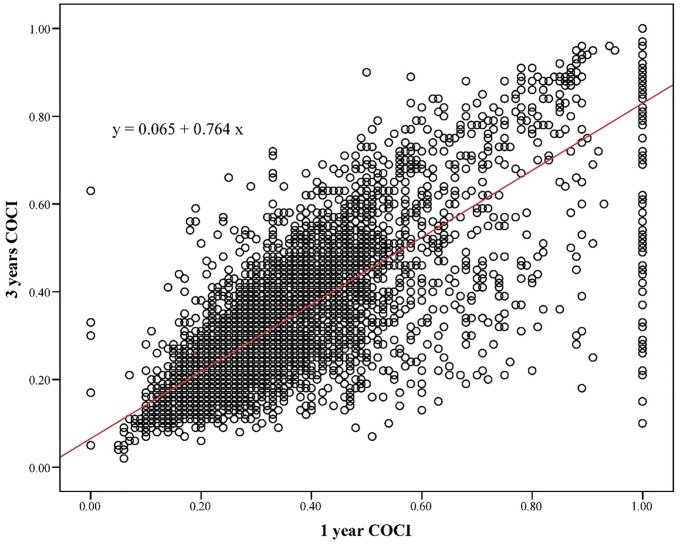
Illustrates the scatter plot between the 1- and 3-year COCI.